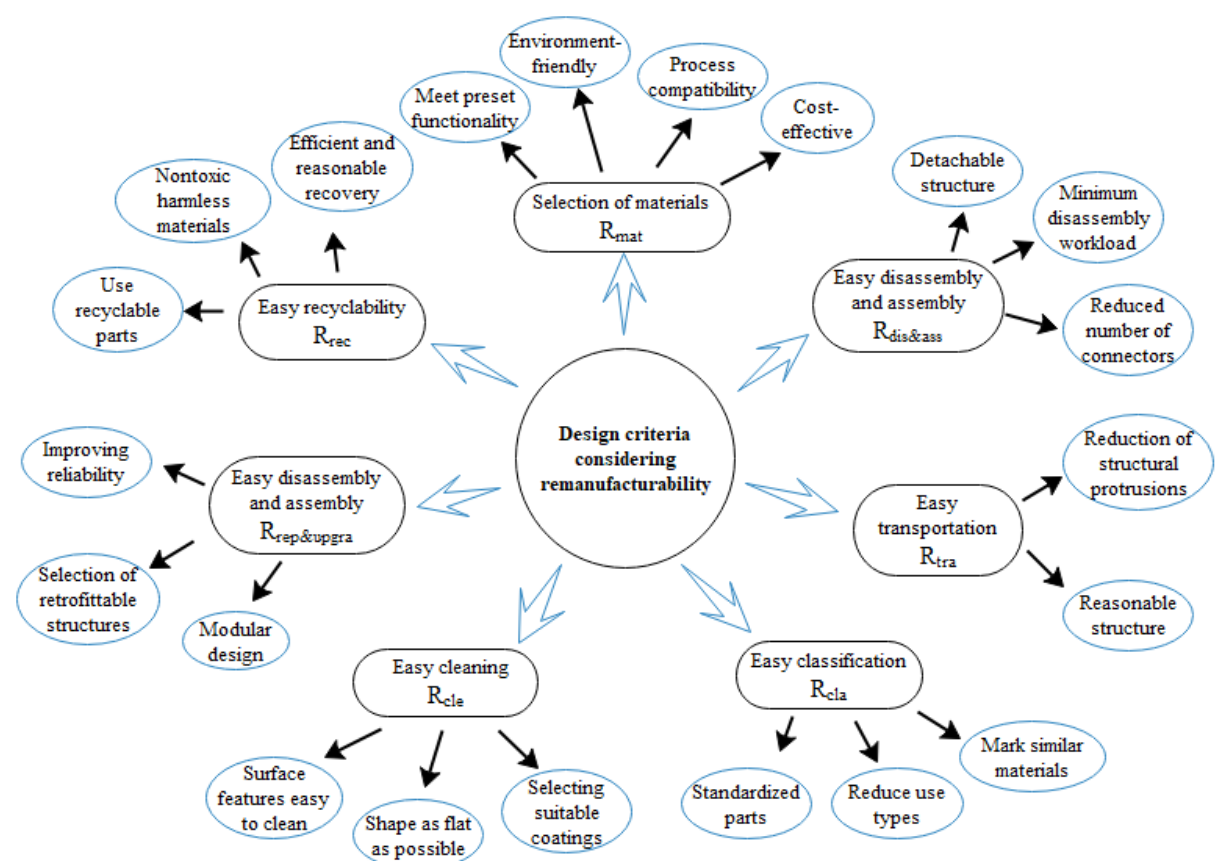
Figure 6. The design criterion diagram while considering remanufacturability.